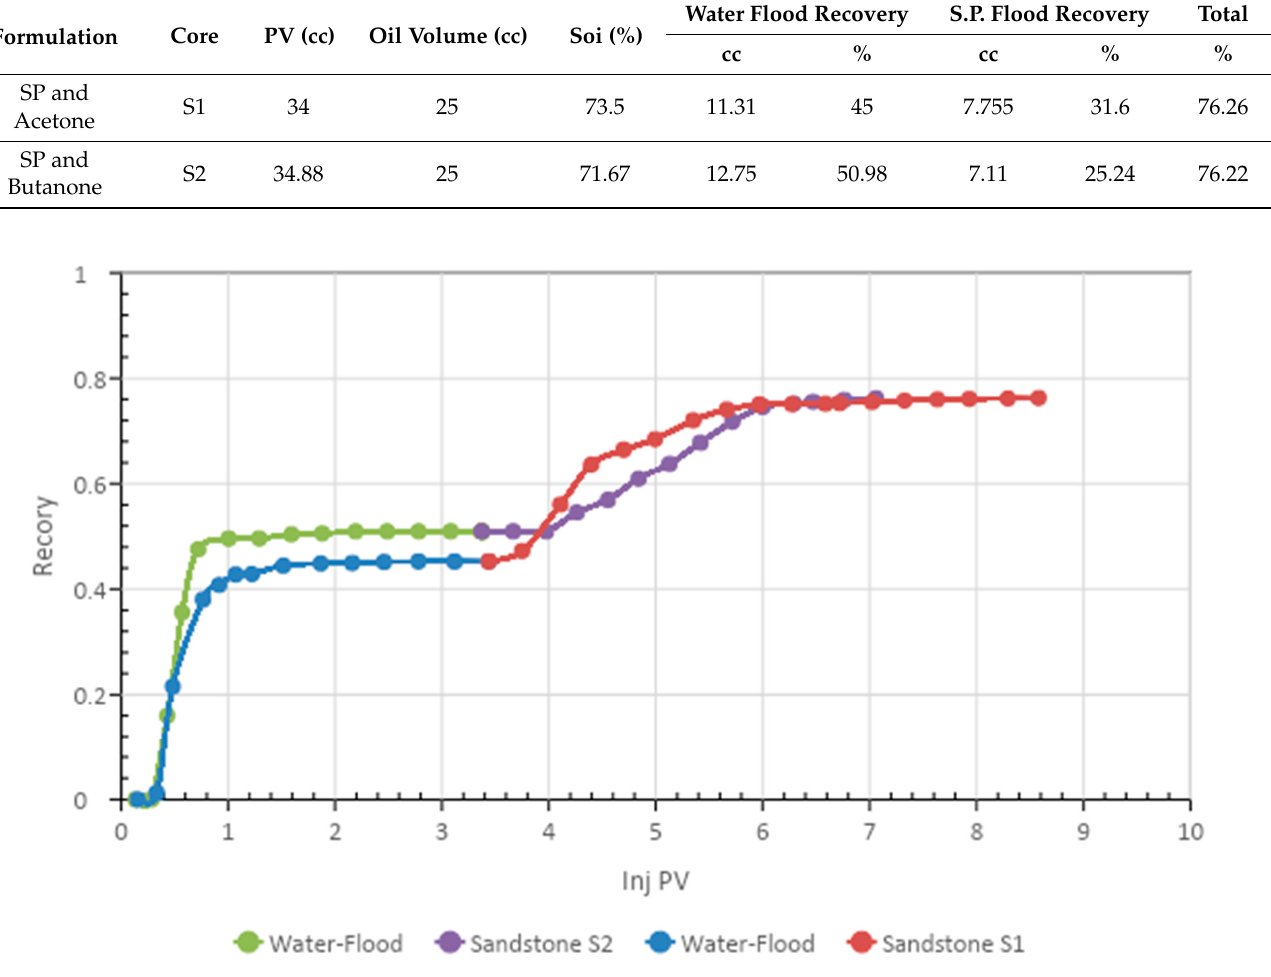
Figure 14. Total oil recovery from the two formulations. 3.4. Simulation of the Core Flooding Experiment The oil recovery performance of the acetone in the SP formulation was better than that of the butanone. For this reason, this formulation was selected to simulate the core flooding experiment. The results were compared with laboratory data to verify simulation accuracy. Secondary and tertiary recoveries were simulated and matched with the history, and then sensitivity studies were performed. The results are shown in the figures below.